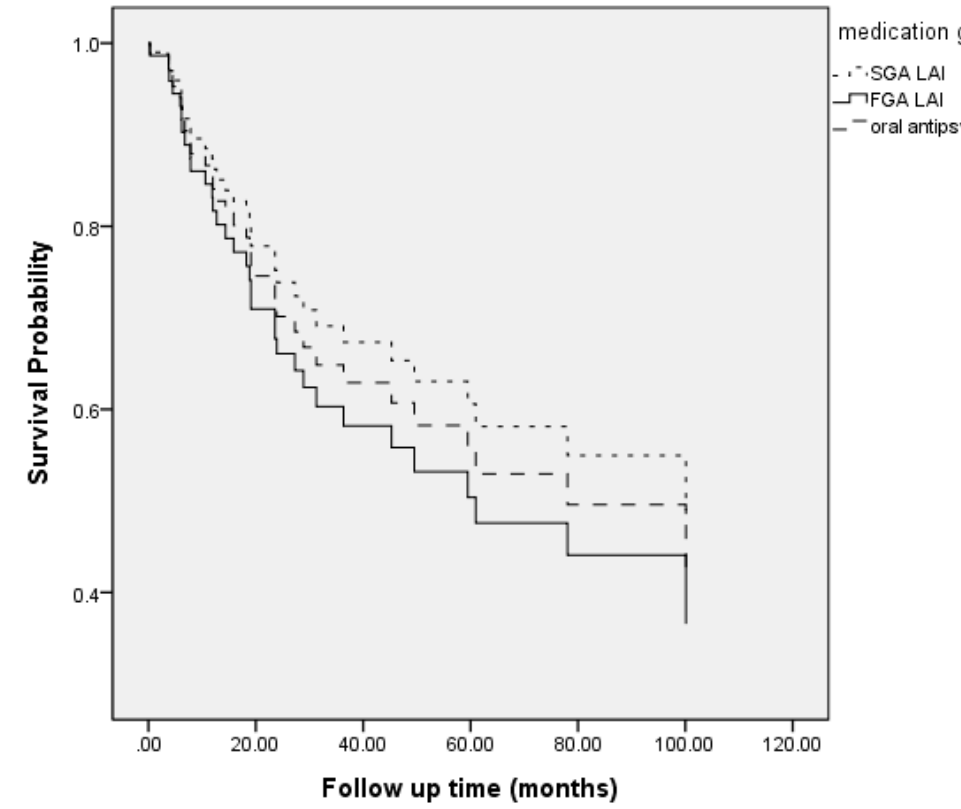
Figure 1. Follow-up time to psychiatric rehospitalization. (FGA LAI: first generation antipsychotics long acting injection; SGA LAI: second generation antipsychotics long acting injection.).